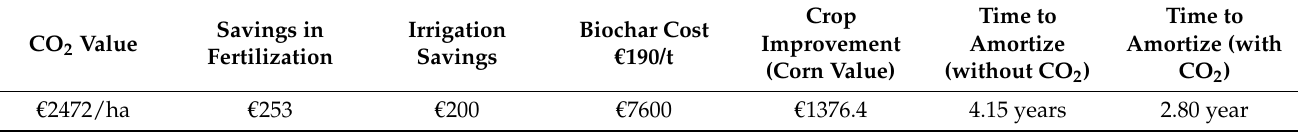
Table 7. Potential savings with the use of